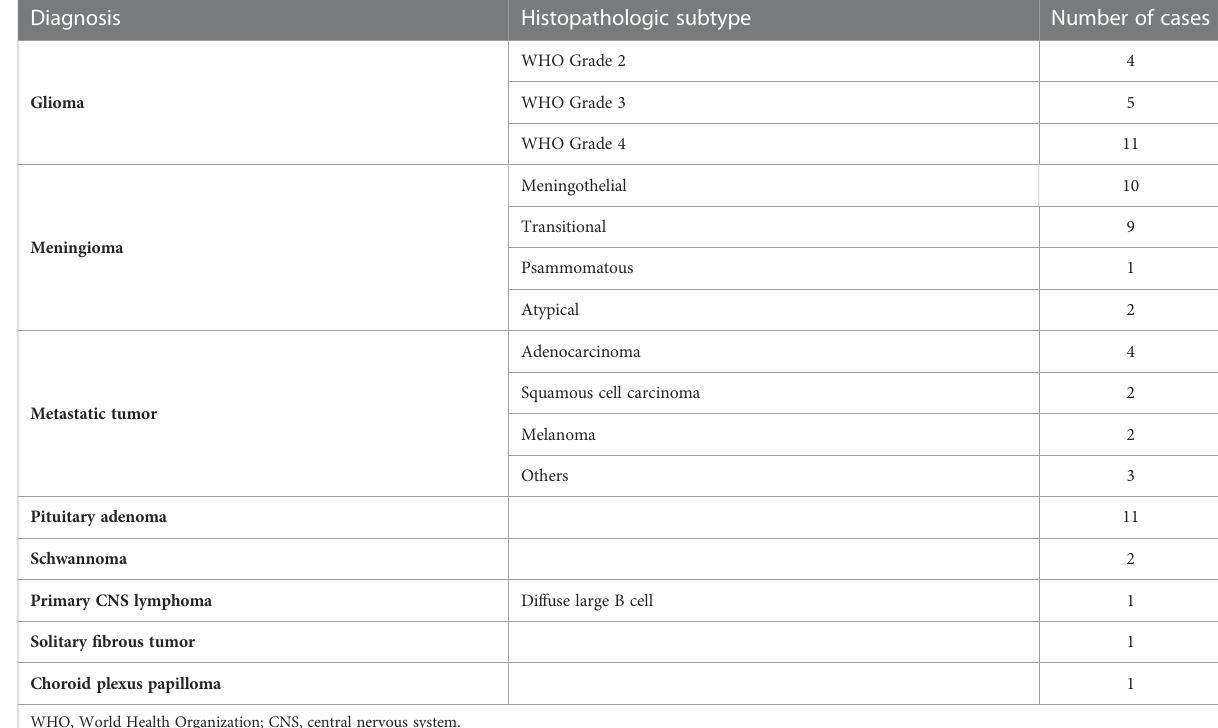
TABLE 1 Histopathologic diagnosis of 69 human brain tumor samples.